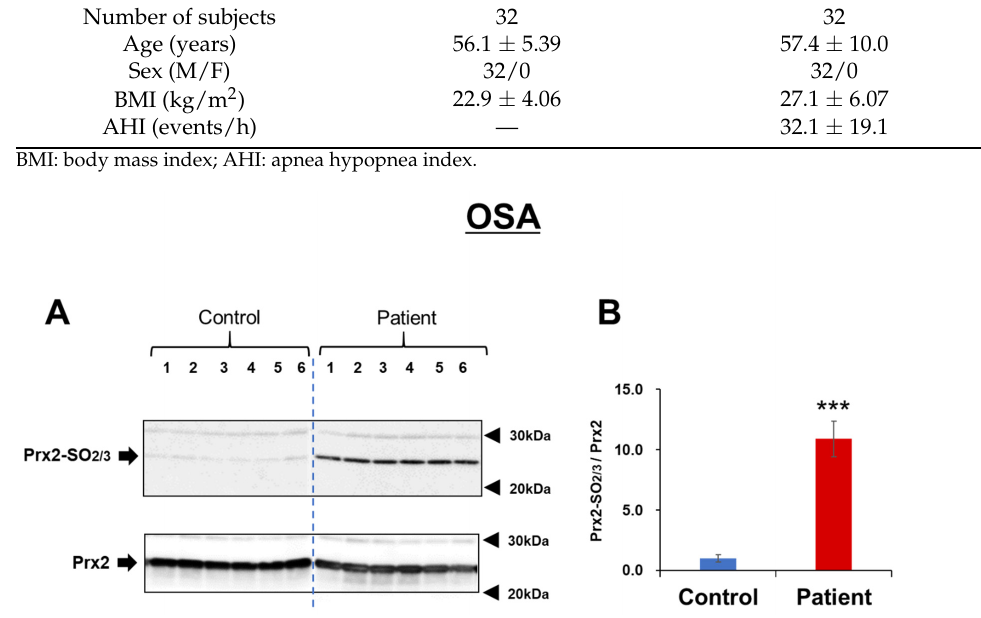
Figure 1. Hyperoxidation of Prx2 in RBC from OSA patients. ( A ): Samples were prepared as described in the Materials and Methods section. Each hemolysate from six patients with OSA (right side; lanes 1, 2: mild; lanes 3, 4: moderate; lanes 5, 6: severe) or six healthy subjects (left side; lanes 1–6) were analyzed by Western blotting with anti-Prx-SO 2/3 antibody (upper image) or anti-Prx2 antibody (lower image) followed with 12.5% SDS-PAGE. ( B ): The density of the Prx2-SO 2/3 bands was measured and normalized to the density of Prx2. The band intensity of the patient group ( n = 6) was expressed as a fold-change relative to the control group ( n = 6). *** p < 0.001 versus control group.